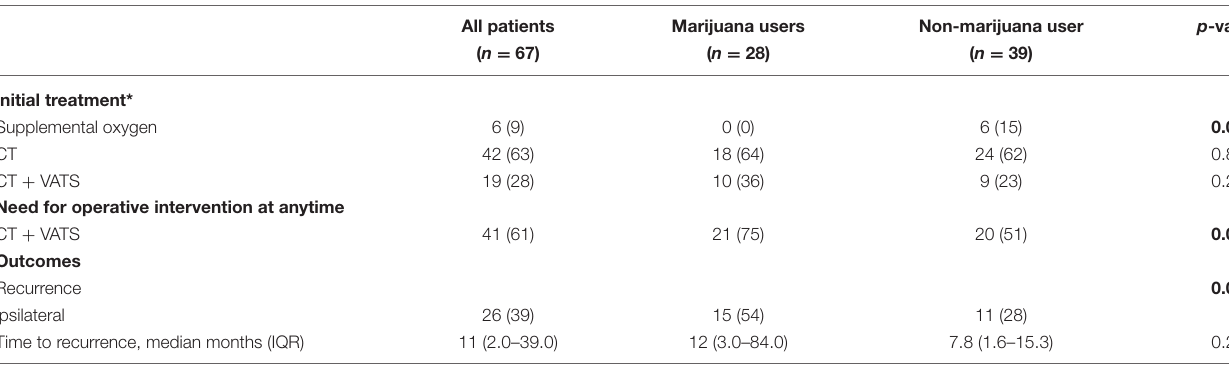
TABLE 2 | Treatment and